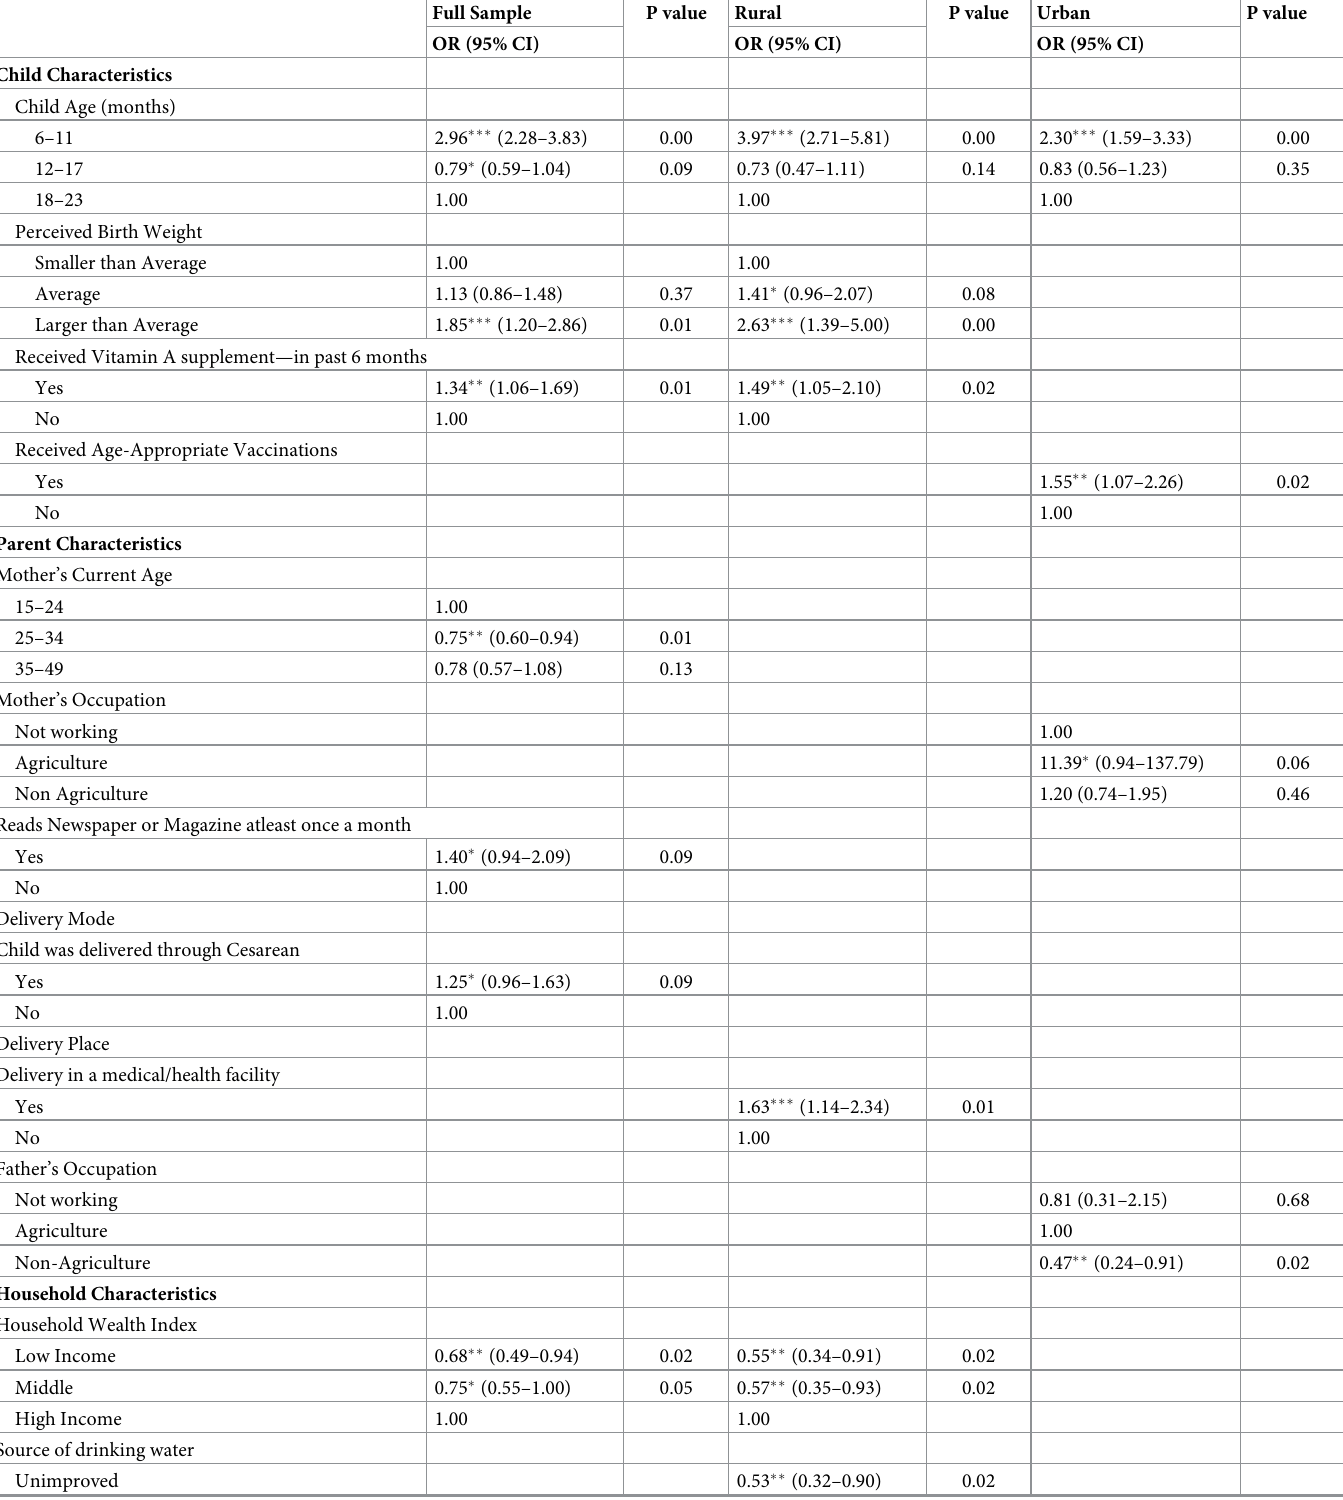
Table 3. Significant correlates (OR (95% CI)) of adequate diet diversity as per WHO recommendations using multivariate logistic